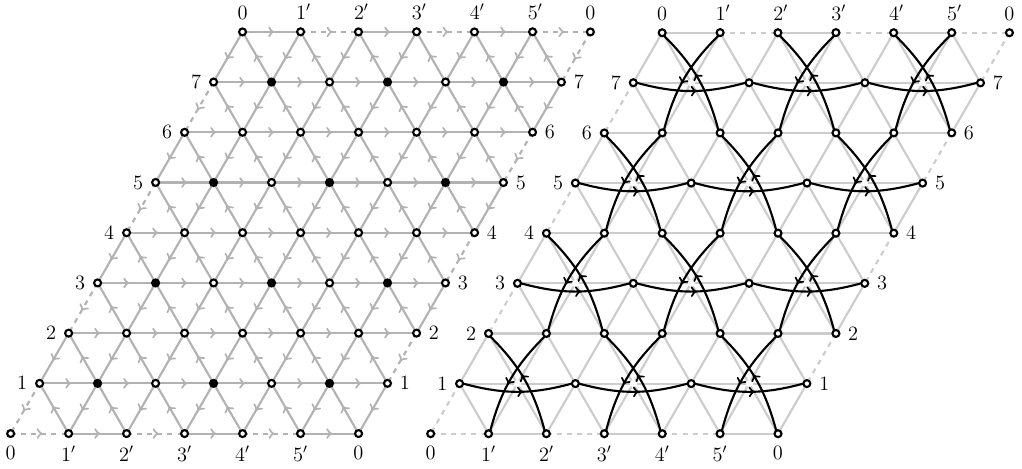
Figure 11 . Left: a T 2 torus, based on a k = 3 × 4 rectangular arrangement with periodic boundaries, is shown here in the UV limit where the gauged SU(3 N ) are asymptotically free. The labels j = 1 . . . 7 and j 0 = 1 0 . . . 5 0 indicate the connections between the boundary nodes. Each pair of SU( N ) j or SU( N ) j 0 nodes on the diagram corresponds to a single gauged SU( N ) ; likewise, the four “ 0 ” nodes represent a single gauged SU( N ) . Right: after the SU(3 N ) groups confine and the vectorlike pairs are integrated out, these SU( N ) × SU( N ) bifundamental mesons are the only charged degrees of freedom. Along the ϕ = 0 ◦ and 240 ◦ directions they form closed loops, with SU( N ) 3 and SU( N ) 4 product groups respectively. For this rectangular k = m × n torus with m 6 = n , the ϕ = 120 ◦ wraps around the torus in a single SU( N ) 12 ring, following 0 → 6 → 4 0 → 4 → 2 0 → 2 → 0